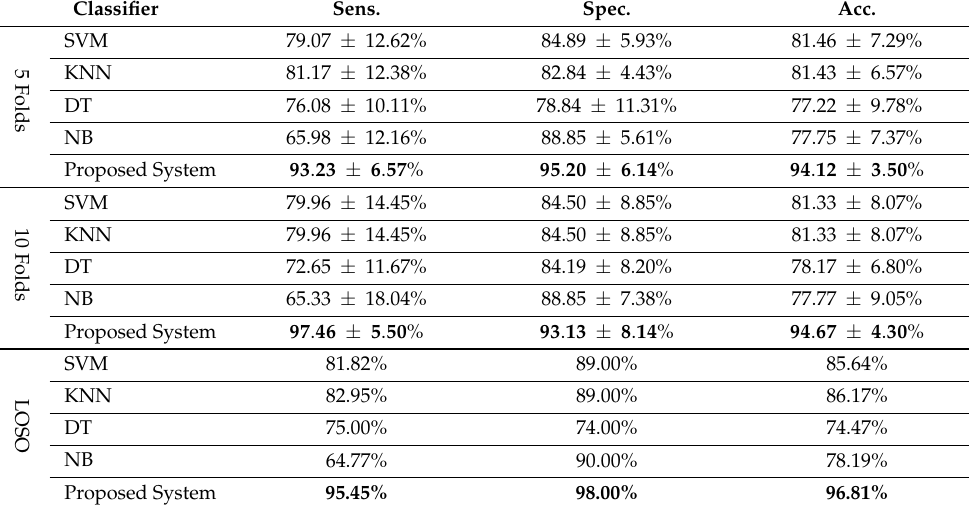
Table 2. Comparison between other ML-based classifications and the proposed system.